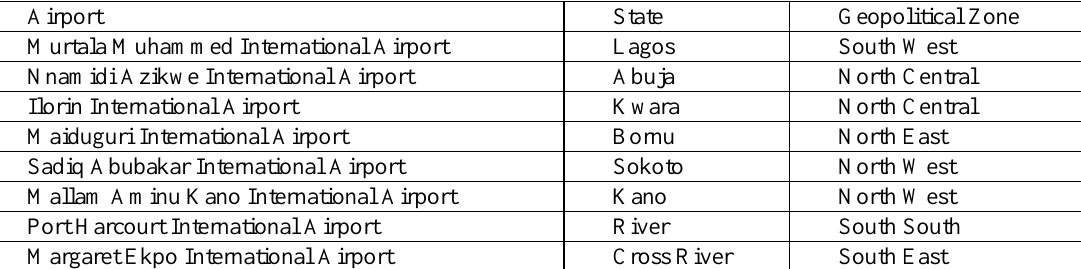
Table 1. location map of international airports in Nigeria.